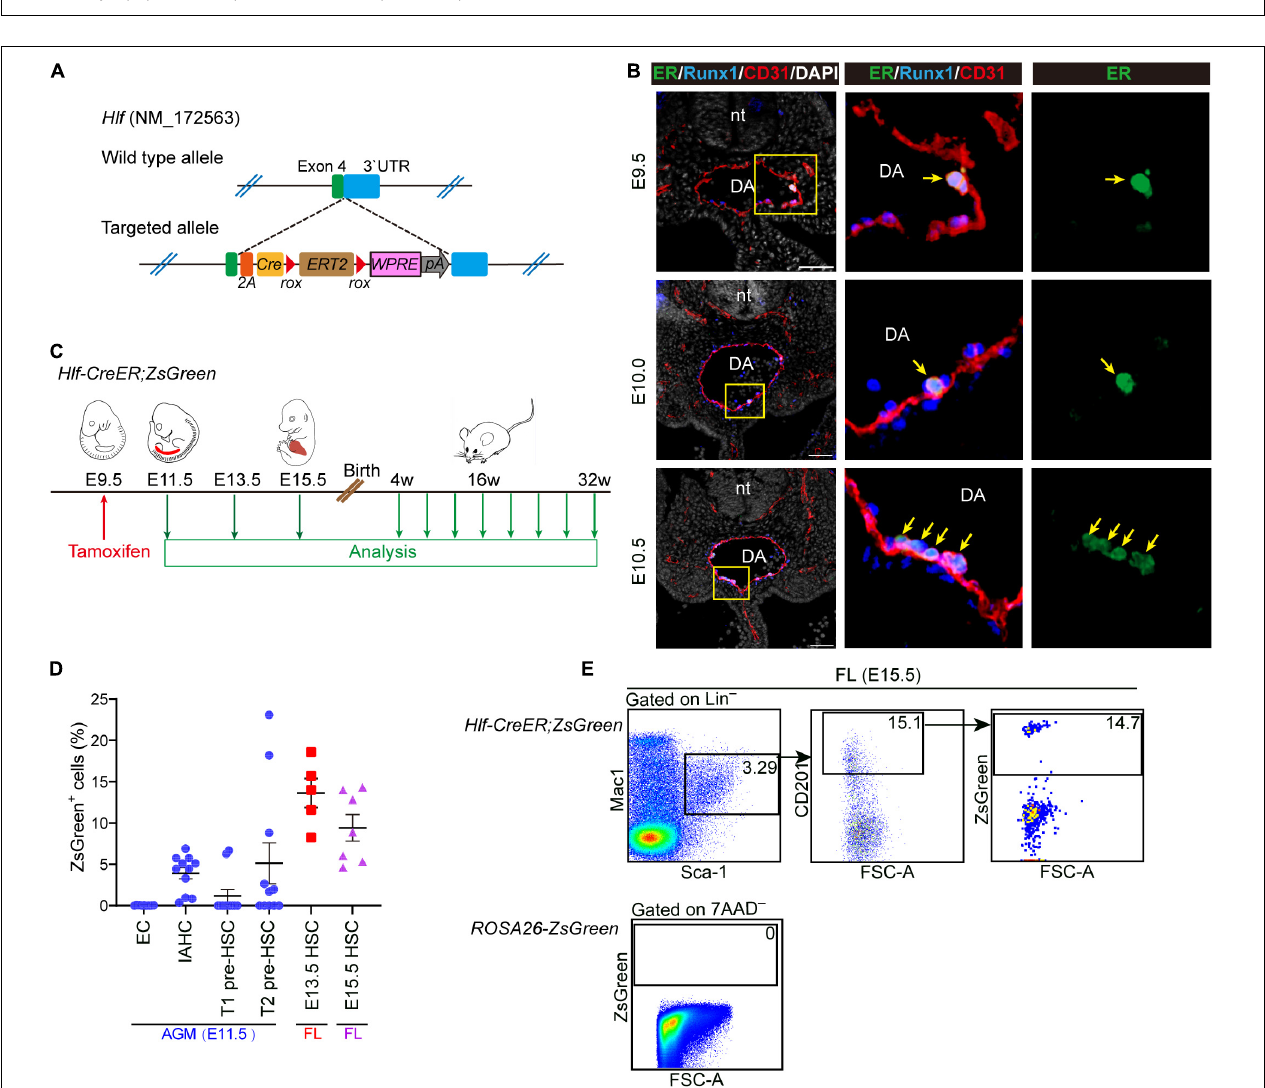
FIGURE 4 | Generation of an inducible Hlf-CreER mouse model. (A) Schematic model of the gene-targeting strategy for constructing Hlf-CreER lineage tracing mouse line via CRISPR/Cas9 system. (B) Representative immunostaining on sections at the E9.5, E10.0, and E10.5 AGM region of Hlf-CreER embryos. Arrows indicate ER + IAHCs. The images to the right present the magnification view of yellow boxes. Scale bar, 50 µ m. (C) Schematic of the experimental design for the genetic lineage tracing with Hlf-CreER;ZsGreen mice. Single dose of induction by tamoxifen injection was performed at E9.5 (red arrow). Green arrows indicate the time points for analyses. The contribution of labeled cells in peripheral blood was chased every 4 weeks for up to 32 weeks after birth. (D) Graph showing the labeled proportions in the indicated populations. EC, endothelial cell. Data are shown as means ± SEM from three independent experiments. (E) Representative FACS plots showing the proportion of labeled cells in the immunophenotypic HSCs (Lin − Sca-1 + Mac-1 lo CD201 + ) in E15.5 fetal liver (FL). Data are representative of four independent